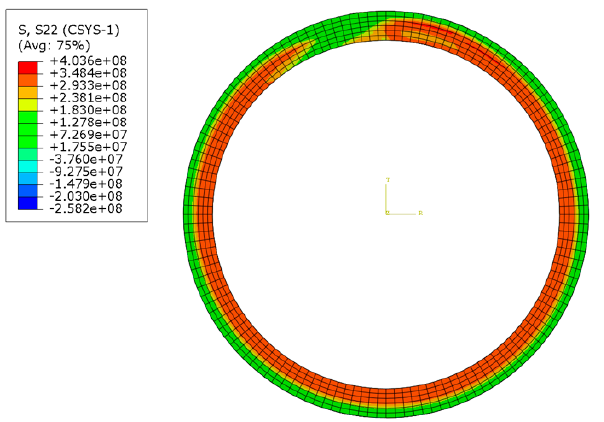
Figure 17. Cross section hoop residual stress distribution (distributions ( z = 156 mm, Section A-A, Figure 2).